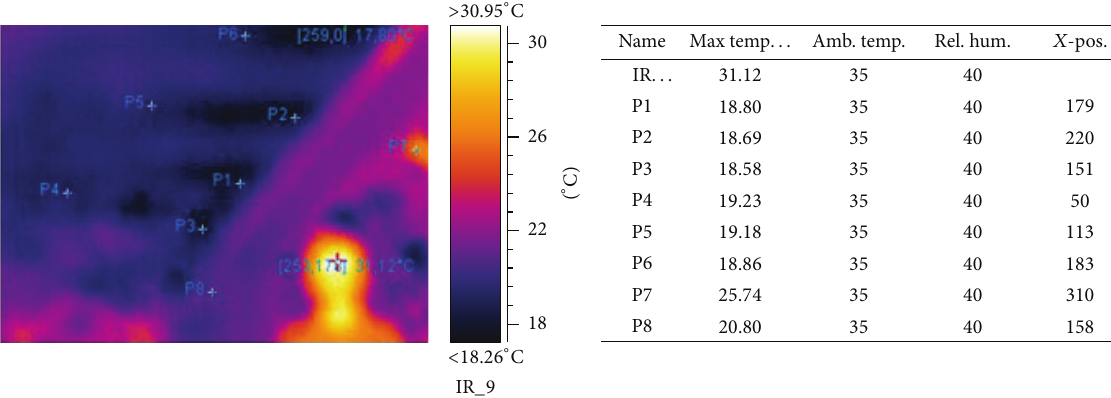
Figure 10: The thermal camera images and information having people under the arbor.